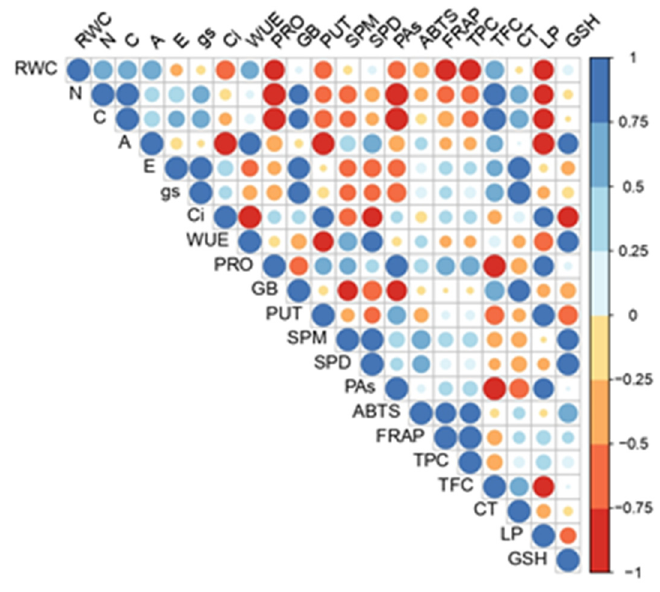
Figure 7. Pearson’s correlation matrix of analyzed physiological and biochemical parameters. *